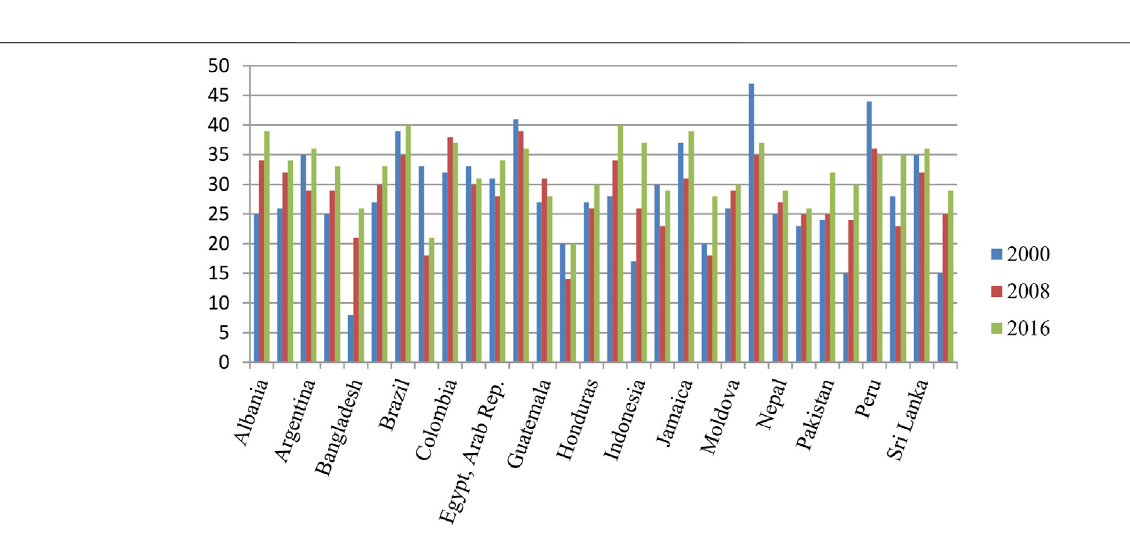
FIGURE 4 | Corruption trends in most corrupt economies. Source: Transparency International